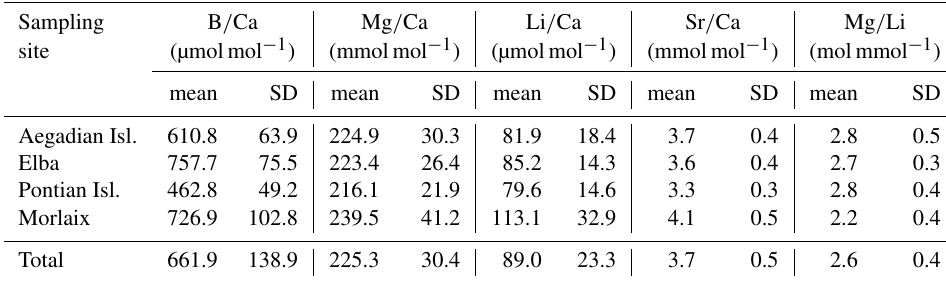
Table 2. Element / Ca ratio measurements in L. corallioides . Sampling B / Ca Mg / Ca Li / Ca Sr / Ca Mg / Li site (µmolmol − 1 ) (mmolmol − 1 ) SD mean Aegadian